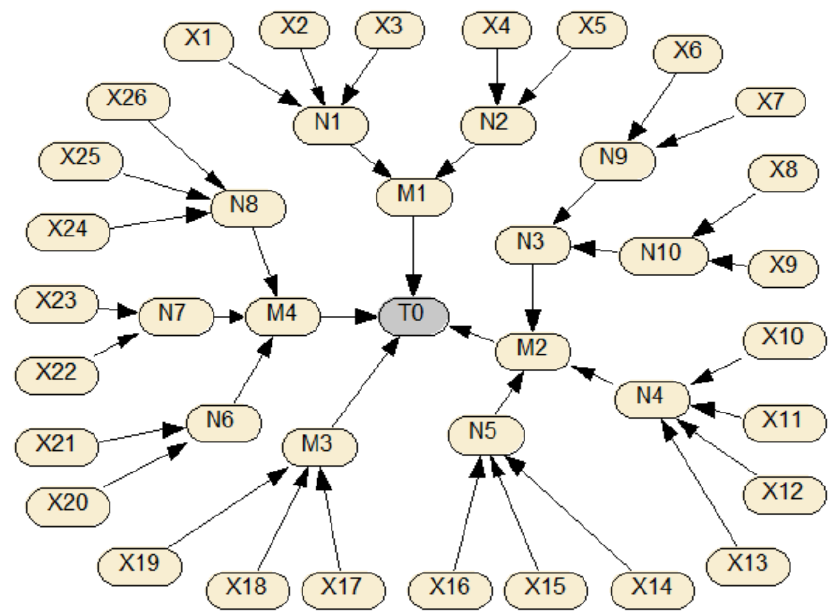
Figure 4. Schemes follow the same formatting.